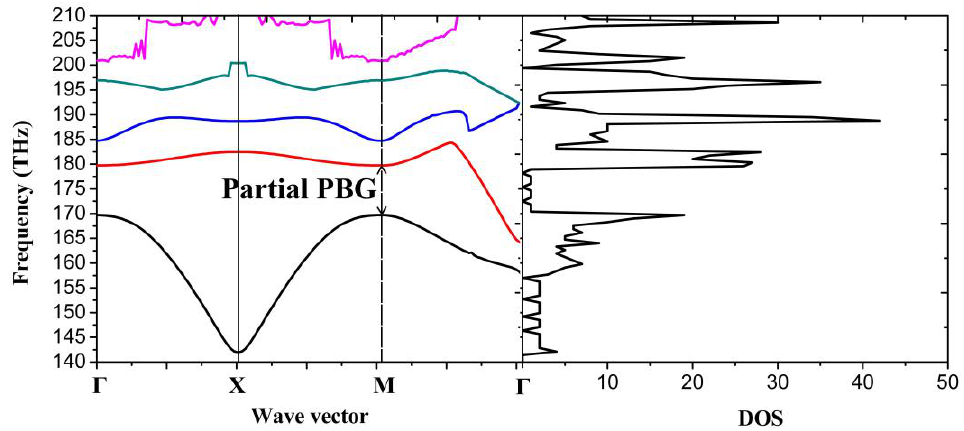
Figure 6. Band structure ( left ) and DOS ( right ) of graphene-based plasmonic 2D PhC with chemical potential μ c1 = 0.6 eV, μ c2 = 0.9 eV, circular radius r = 5 nm, and lattice constant a = 20 nm.